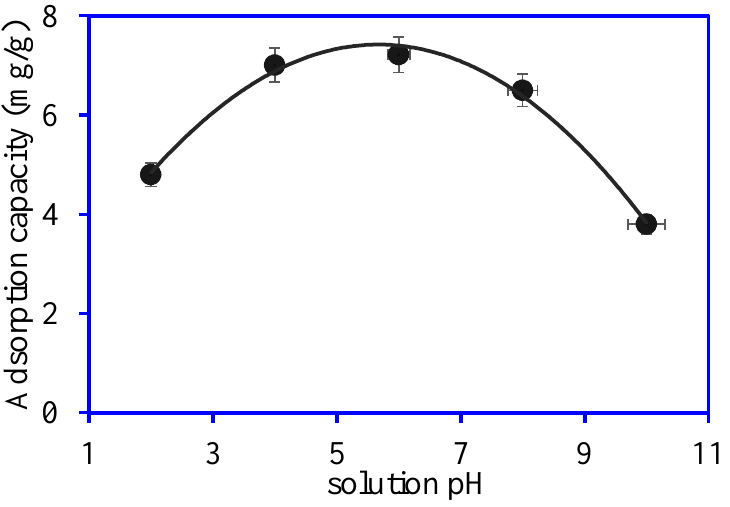
Figure 9. Plot for OTC adsorption at different solution pH onto Ni 3 S 4 /Ag 2 S/TiO 2 /CA aerogel. (OTC conc.: 10 mg/L, aerogel mass: 0.03 g, OTC volume: 30 mL, time: 180 min). The adsorption isotherm studies of OTC onto Ni 3 S 4 /Ag 2 S/TiO 2 /CA were investigated at varying initial concentrations between 5 mg/L to 50 mg/L, as shown in Figure 10. The OTC adsorption rate increases with the increase in the OTC molecules in the solution from 5 mg/L to 30 mg/L. A saturation of Ni 3 S 4 /Ag 2 S/TiO 2 /CA active sites has been observed beyond 30 mg/L, meaning that equilibrium between OTC and Ni 3 S 4 /Ag 2 S/TiO 2 /CA has been established. At lower concentrations, OTC molecules are present in fewer numbers, and many active sites on Ni 3 S 4 /Ag 2 S/TiO 2 /CA are available for adsorption. As the ratio between OTC molecules and active sites reduces, Ni 3 S 4 /Ag 2 S/TiO 2 /CA surface sites reach equilibrium